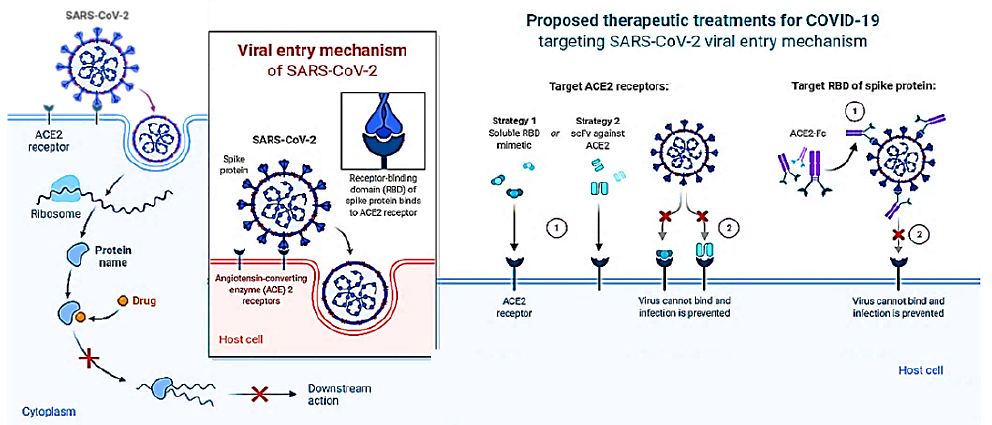
Figure 7. Schematic illustration of the COVID-19 Drug Mechanism of Action.